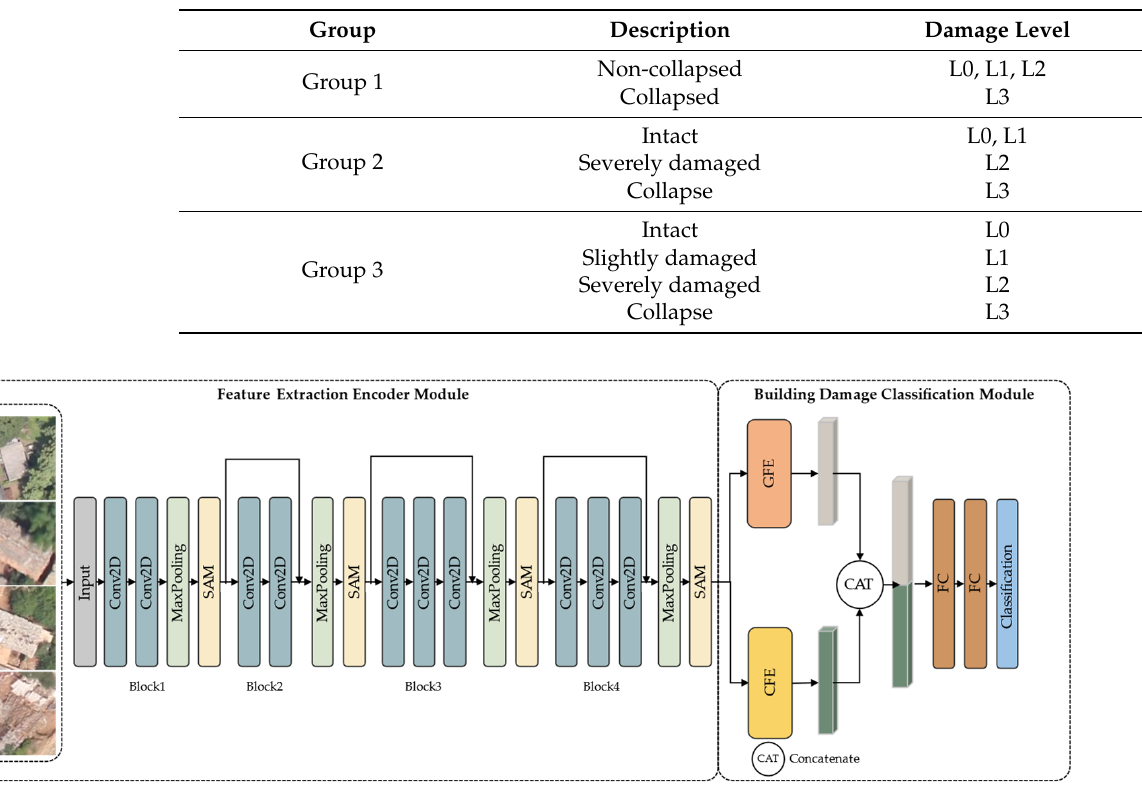
Table 3. Distribution of building damage levels for the three classification criteria.